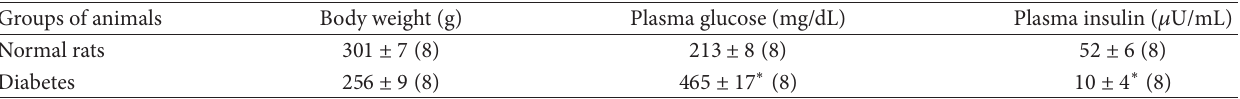
Table 1: Body weight, plasma glucose, and plasma insulin concentration in normal and streptozotocin-induced diabetic rats. Groups of animals Body weight (g) Plasma glucose (mg/dL) Plasma insulin ( 𝜇 U/mL) Normal rats 301 ± 7 (8) 213 ± 8 (8) 52 ± 6 (8) Diabetes 256 ± 9 (8) 465 ± 17 ∗ (8) 10 ± 4 ∗